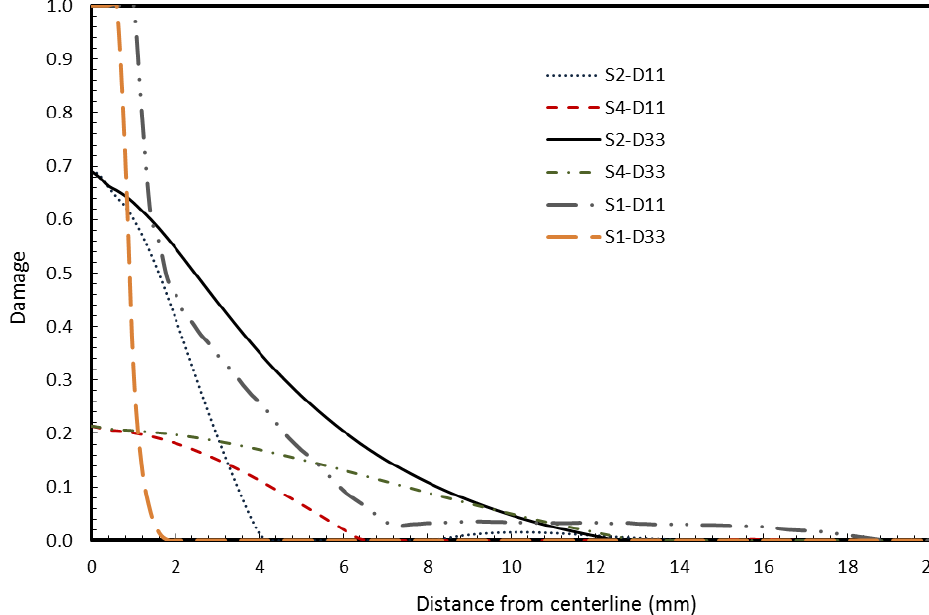
Figure 6. Damage variables D S2 and surface S4 for small missile impact.